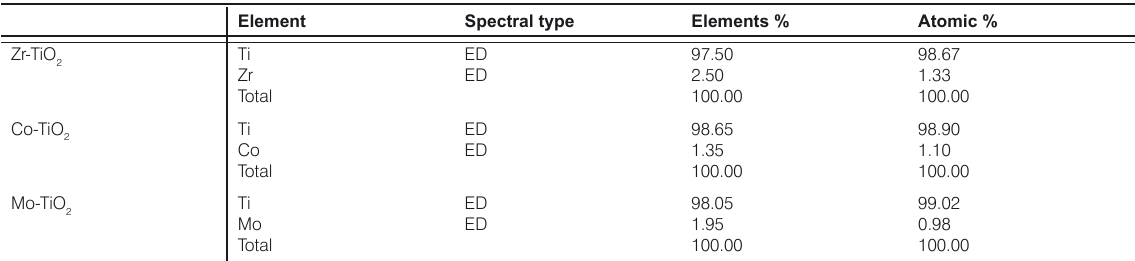
Table 1. EDX analysis of the Photocatalysts.